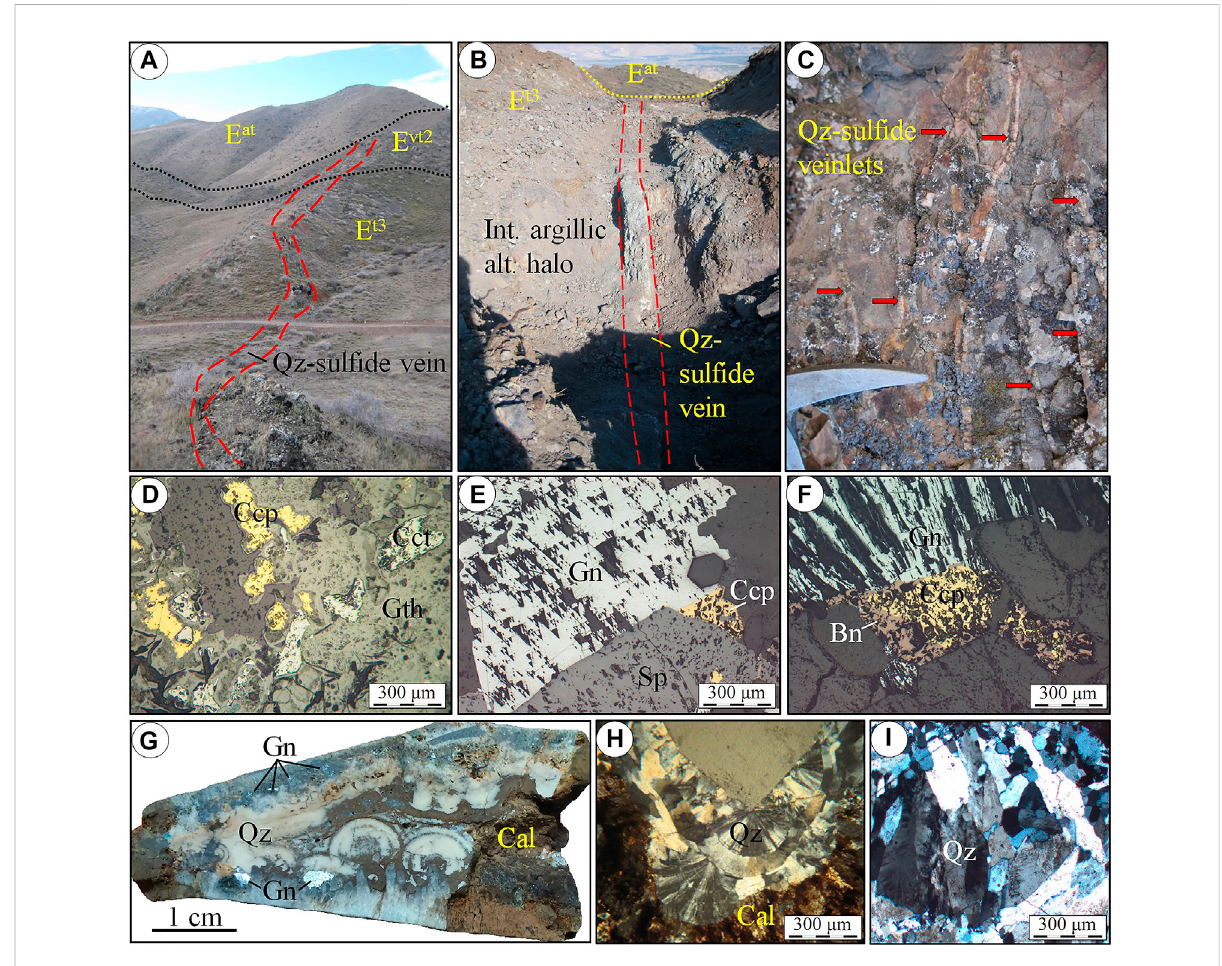
FIGURE 3 Photographs are showing characteristics of the ore veins, mineralogy, and textures at the Tashvir deposit. Images in (D – F) are from polished blocks in re fl ected light, while H and I are taken in transmitted light, XPL. (A) . General view of the main quartz-sul fi de vein hosted by the E t3 and E vt2 units of the Karaj Formation, looking northeast. (B) . Quartz-sul fi de vein surrounded by 2 m wide intermediate argillic alteration halo, looking northeast. (C) . Sheeted mineralized quartz-sul fi de veins (red arrows) within the hydrothermal alteration haloes of the main ore veins. (D) . Anhedral chalcopyrite is intergrown with chalcocite. (E) . Subhedral coarse-grained galena intergrowth with sphalerite and chalcopyrite. Sphalerite enclosed chalcopyrite inclusions. (F) . Galena intergrowth with chalcopyrite. Chalcopyrite was replaced by bornite. (G,H) . Colloform/crustiform texture of quartz vein. Calcite fi lls the vugs. (I) . Quartz veins with plumose texture. Bn: bornite, Br: braunite, Cal: calcite, Ccp: chalcopyrite, Cct: chalcocite, Cer: cerussite, Gn: galena, G th: goethite, Lith: tuff fragment, Py: pyrite, Pyr1: primary pyrolusite, Pyr2: secondary pyrolusite,